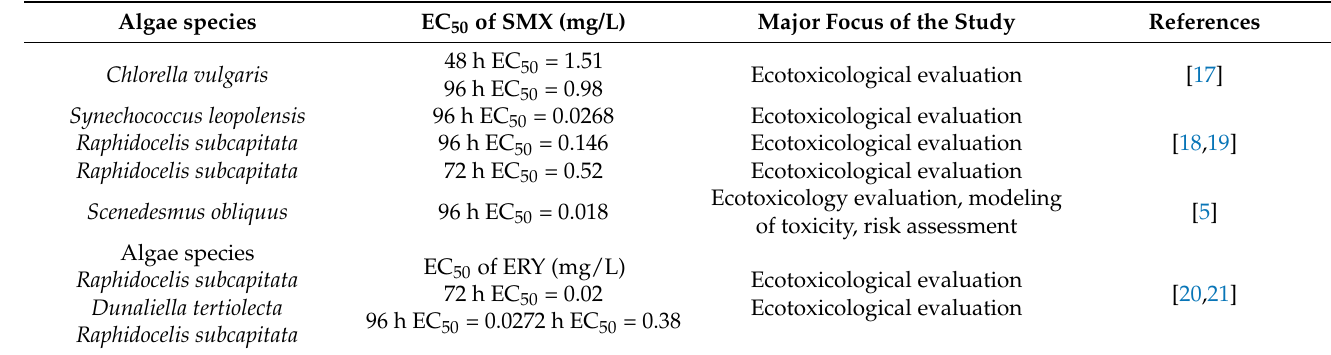
Table 2. Summary of ecotoxicological effects of SMX and ERY on microalgal species in terms of growth inhibition, obtained in this study and compared with previously reported